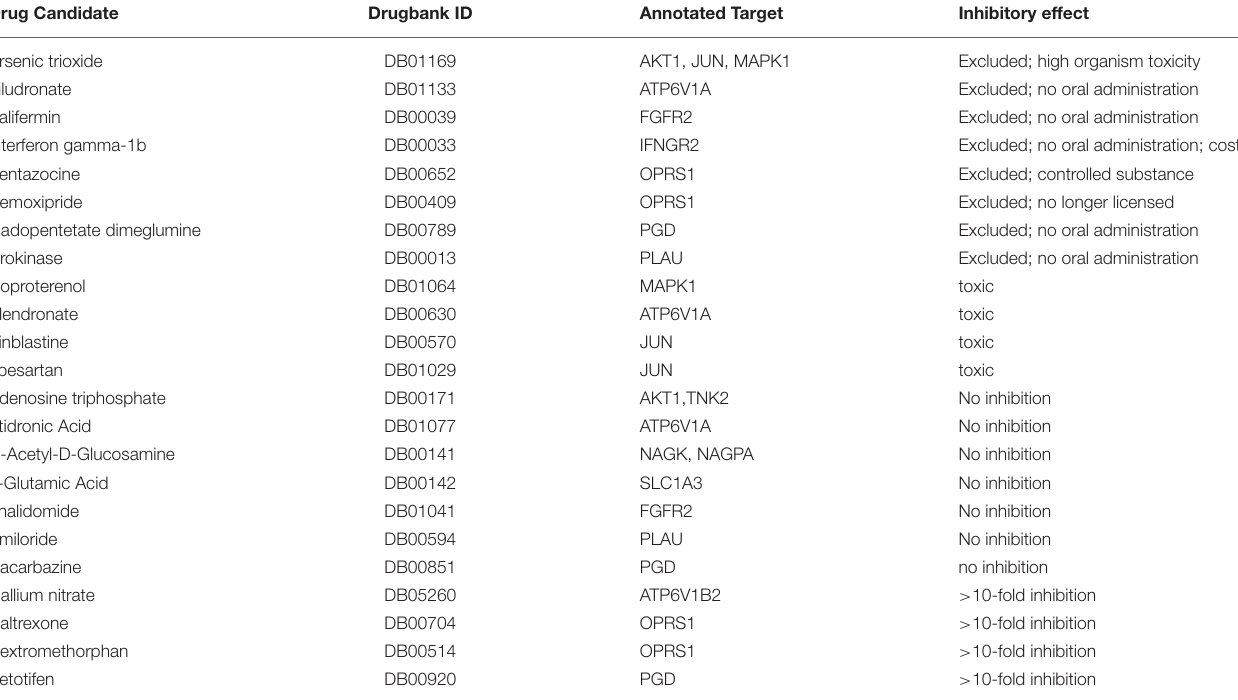
TABLE 1 | Inhibition of influenza A virus replication by licensed drugs with Drug ID and cellular targets identified by bioinformatics